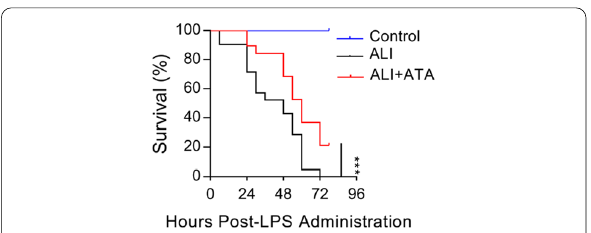
Fig. 4 Therapeutic blockade of Fn14 by ATA improves the survival of LPS‑treated mice. ATA (20 mg/kg) was administered to mice 2 h after induction of ALI by LPS (25 mg/kg). The mortality of the mice was monitored every 6 h over 96 h ( n 20). Survival data were analyzed = using the log‑rank test. *** P <